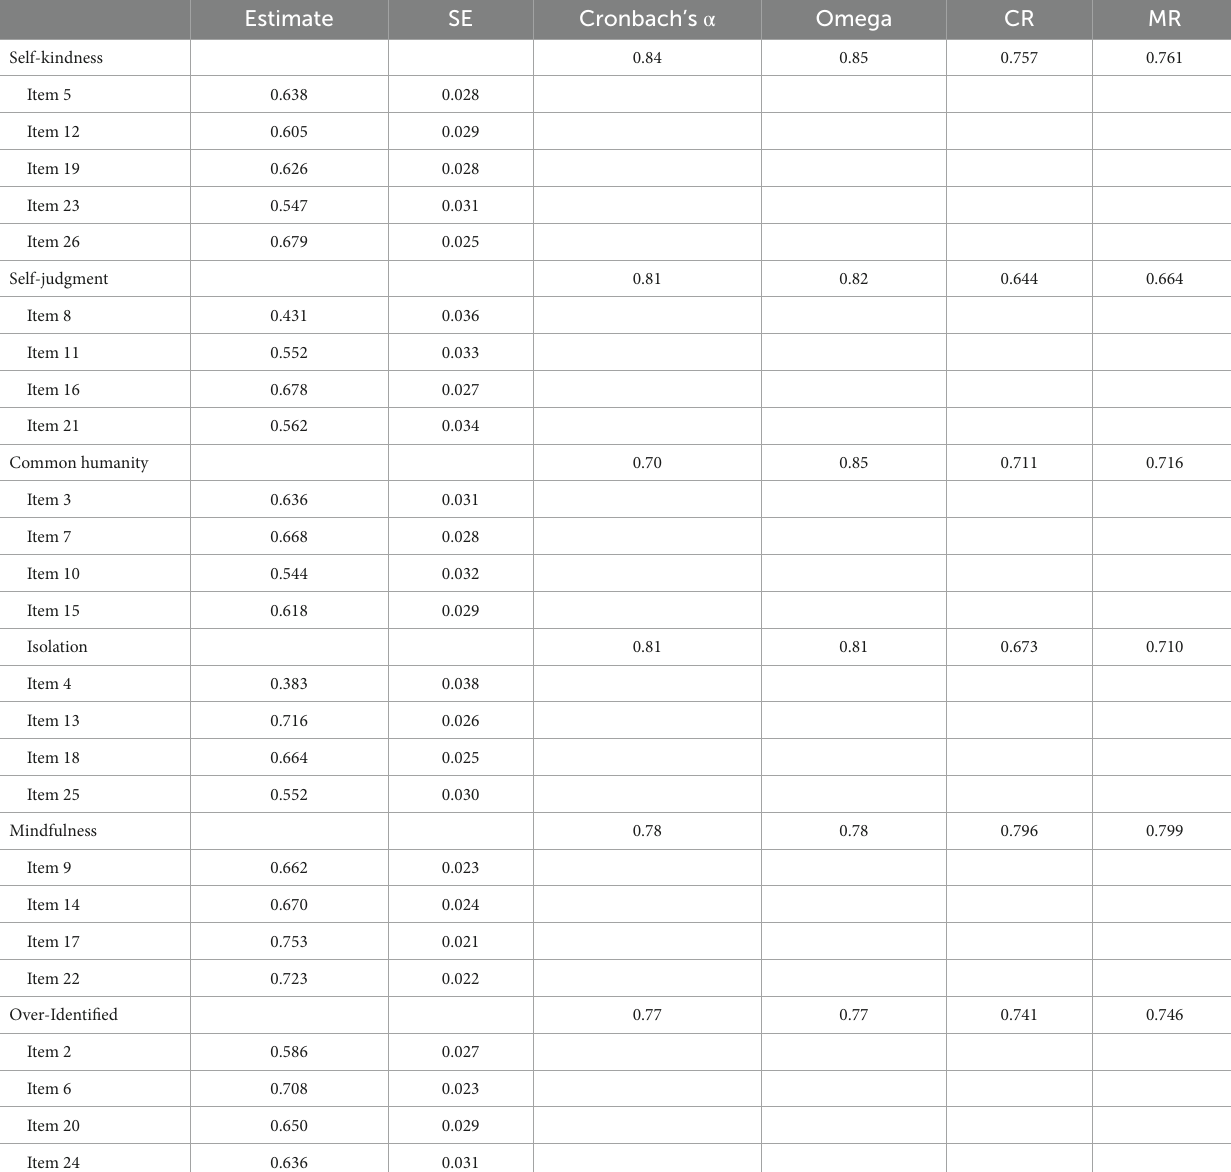
TABLE 4 Factor loadings and